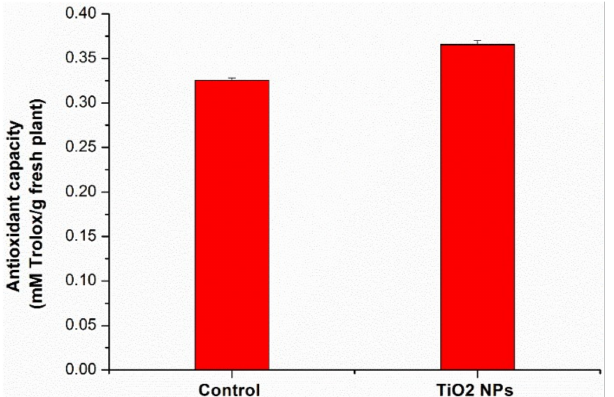
Figure 6. The antioxidant capacity of wheat extracts. Each data point is the mean ± the standard error of the mean of three independent replicates